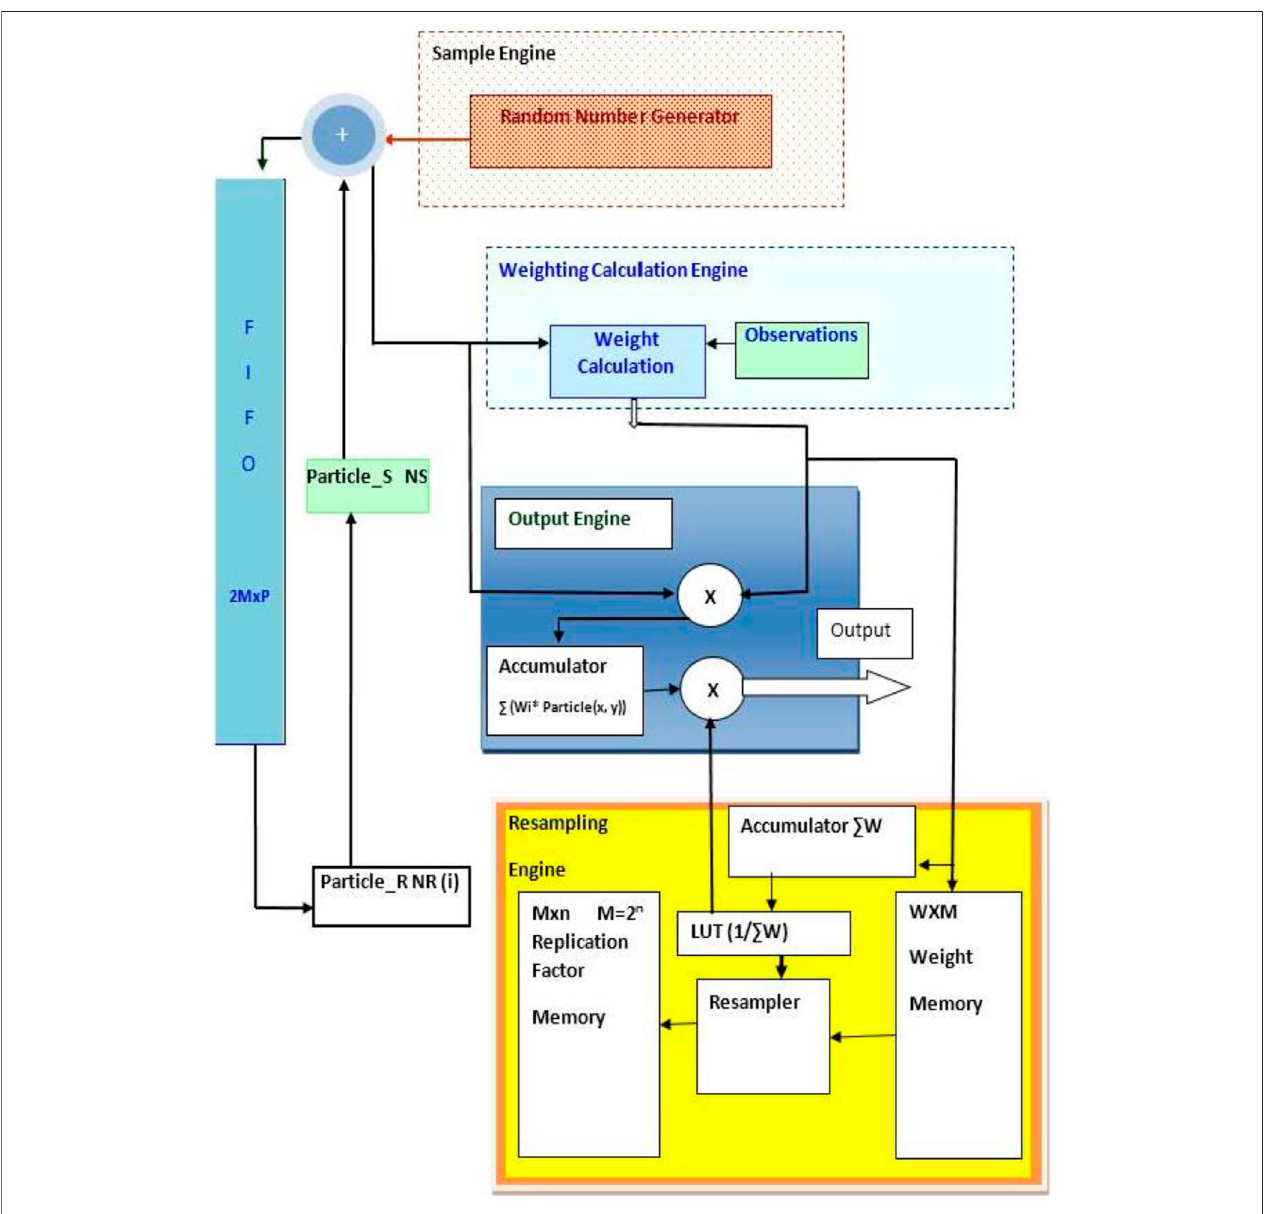
FIGURE 8 | SIRF Localizer processor architecture.